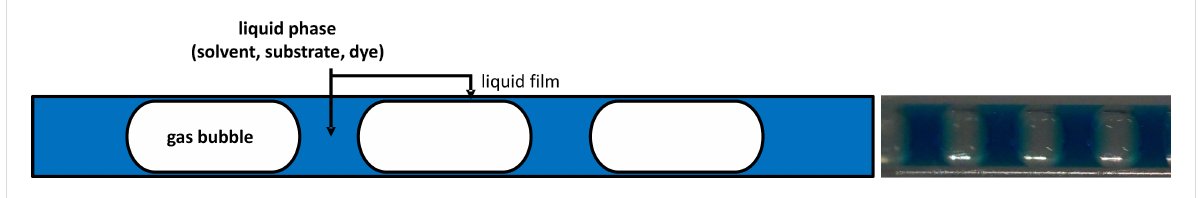
Scheme 3: Slug flow conditions of two-phase gas-liquid mixtures. Photograph of a slug flow of a solution of methylene blue (1.0 mM), a cyclohexene (0.1 M), oxygen at 30 bar, and 1.5 mL min − 1 flow rate in an FEP tubing reactor (0.79 mm inner diameter).